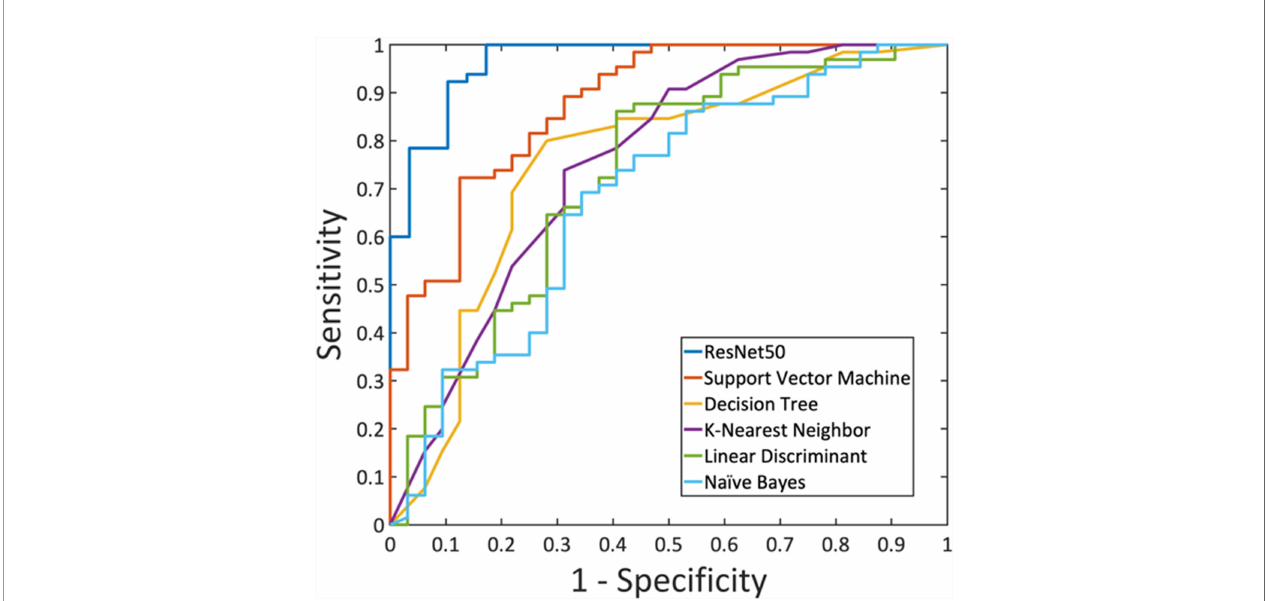
FIGURE 6 | The ROC curves generated from the predicted per-lesion malignancy probability in the training dataset, by using ResNet50 and the fi ve radiomics models built using: Support Vector Machine, Decision Tree, K-Nearest Neighbor, Linear Discriminant Analysis, and Naïve